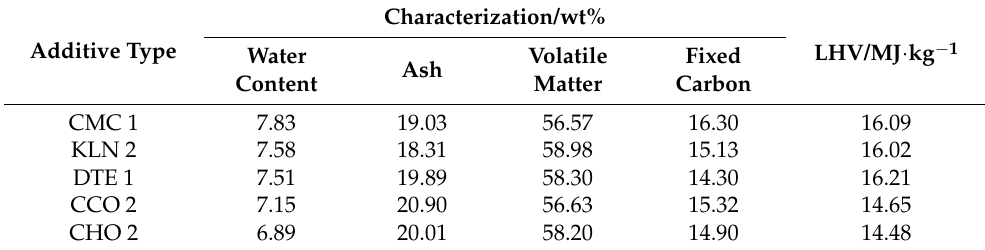
Table 4. Industrial analysis and low heat value (LHV) of test treatment after screening.